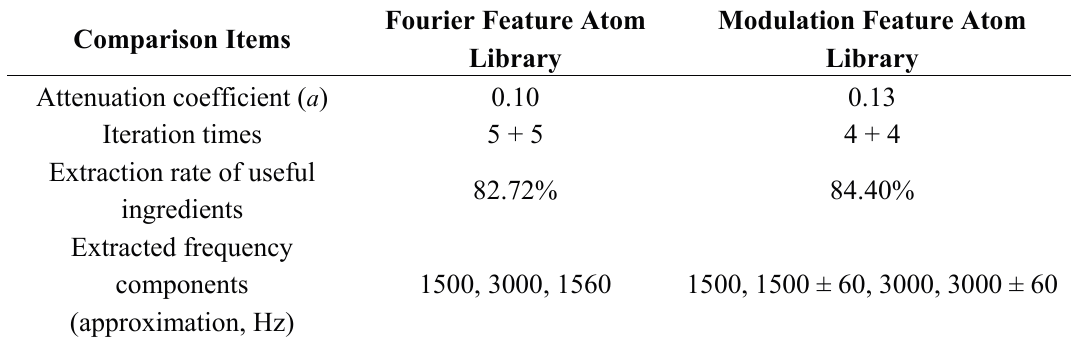
Table 2. Comparison of the